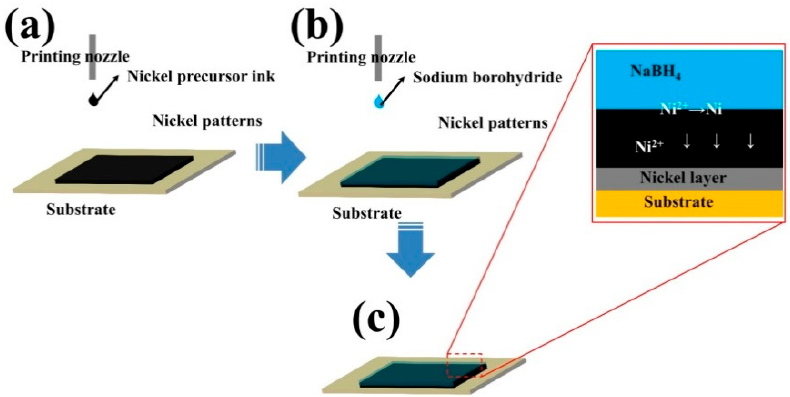
Figure 1. Schematics of nickel printing: ( a ) nickel precursor printing; ( b ) reducing agent printing on the nickel precursor layers; ( c ) metallic nickel formation through the chemical reaction, the inset showing the cross section view of the chemical reaction in nickel precursor multi-printing method [14].